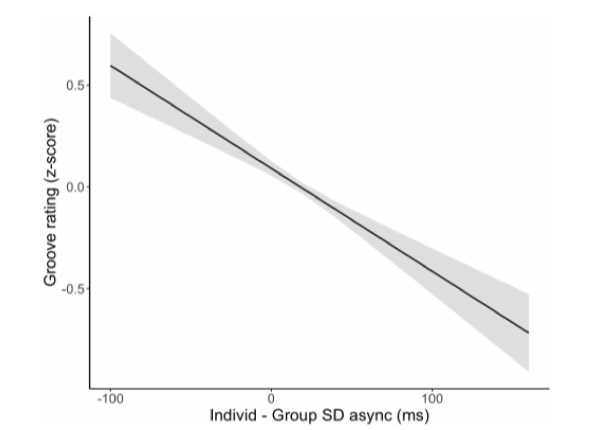
FIGURE 7 | Predicted groove ratings as a function of individuals’ SD async differences from the group, adjusted for random effects of adaptivity, participant, group, and experiment (see model reported in Table 5